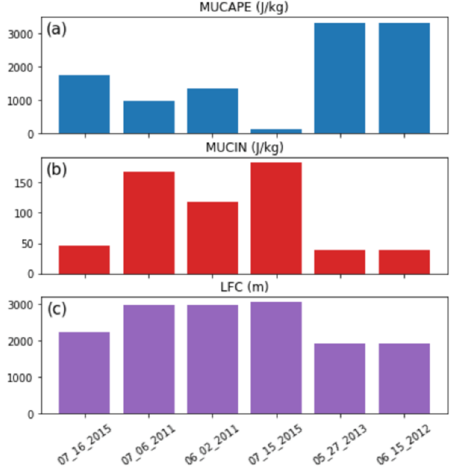
Figure 6. Low-level wind magnitude (m s (cid:2879)(cid:2869) ) and direction within the Obs-inflow region for six Type A cases (month, day, and year shown below each panel). Cross-section taken across the en- tire region from west to east at the halfway position from north to south across domain. Top row ( a – c ) are cases that contained a small X-component distance error, yet a large specific humidity mean error, while the bottom ( d – f ) are cases that contained a large X-component distance error, yet a small specific humidity mean error. Speeds indicated with color bar on the right.